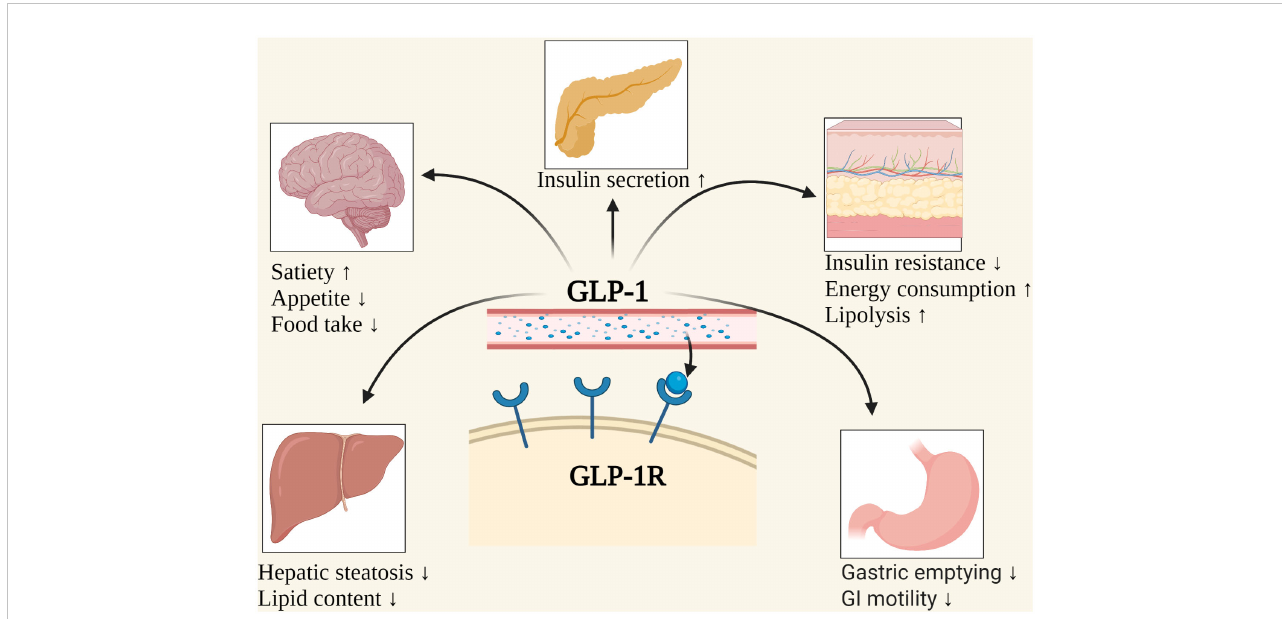
FIGURE 1 The possible mechanisms of weight loss caused by GLP-1. GI, Gastrointestinal; GLP-1, Glucagon-like peptide-1; GLP-1R, Glucagon-like peptide-1 receptor. Created with